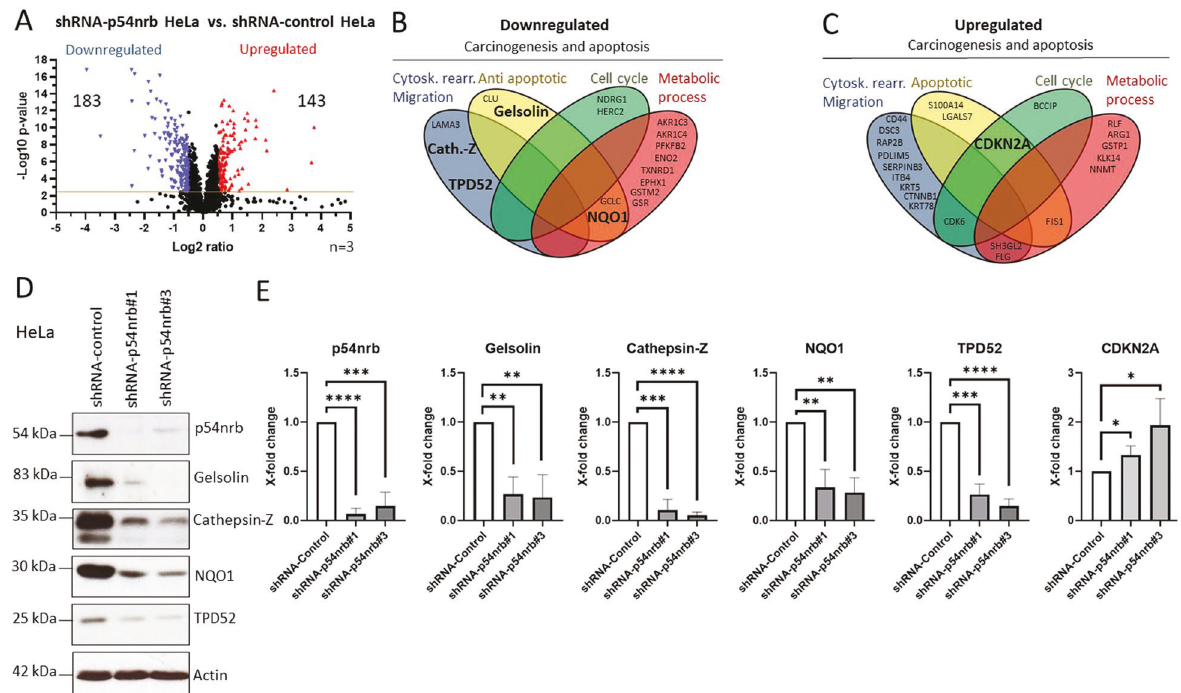
Fig. 3 Loss of p54nrb leads to an altered expressional pattern of carcinogenesis relevant genes. A Volcano plot diagram of LC/MS data derived from the analysis of HeLa shRNA-control versus shRNA-p54nrb cells. ( n = 3). Arrowheads depict signi fi cantly ( p < 0.01) upregulated (arrow up, red) and downregulated (arrow down, blue) proteins, and the total numbers of both categories are indicated on the diagram. B Up- and C downregulated proteins ( p < 0.01, Log 2 ratio either >0.5 or < − 0.5) of HeLa-shRNA-p54nrb cells compared to shRNA control cells, which exert tumor regulatory and/or apoptosis regulatory properties. Differently colored oval diagrams represent various functional subcategories of these hits. D Immunoblot of HeLa shRNA-control and shRNA-p54nrb cells. Detection of p54nrb, gelsolin, cathepsin-Z, NQO1, and TPD52 levels. E Quantitative evaluation of immunoblots of p54nrb, gelsolin, cathepsin-Z, NQO1, TPD52, and CDKN2A from HeLa shRNA-control and shRNA-p54nrb#1 and #3 cells. The bands were normalized to the shRNA-control samples. Signi fi cance was calculated with one sample t test, * p < 0.05, ** p < 0.01, *** p < 0.001, **** p < 0.0001, n =